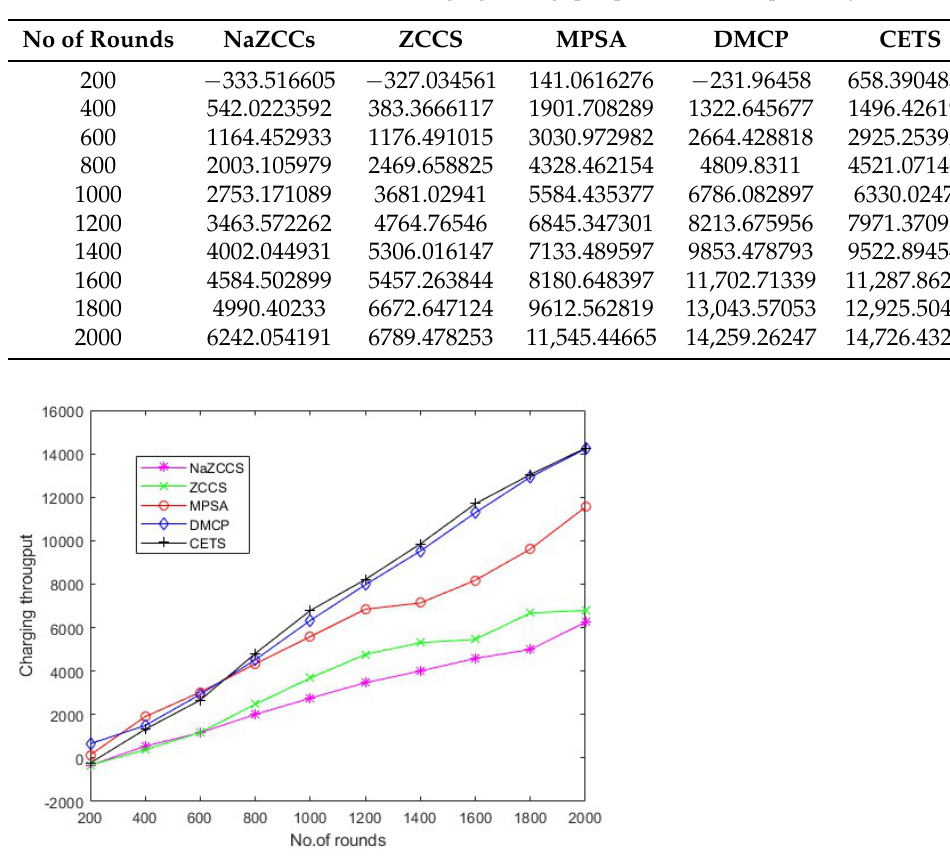
Table 10. CETS versus other models on charging throughput per round at hop density 0.3.